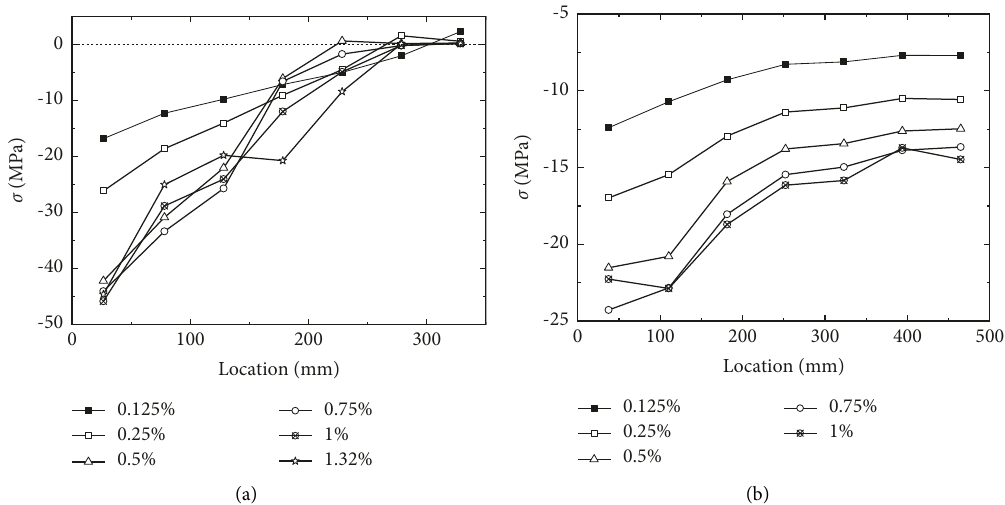
Figure 17: Concrete stress distributions at different loading steps (FEA). (a) CW4X-D( l / h � 1.5, n � 0.1). (b) CW4X-1( l / h � 1.5, n � 0.1) [31].